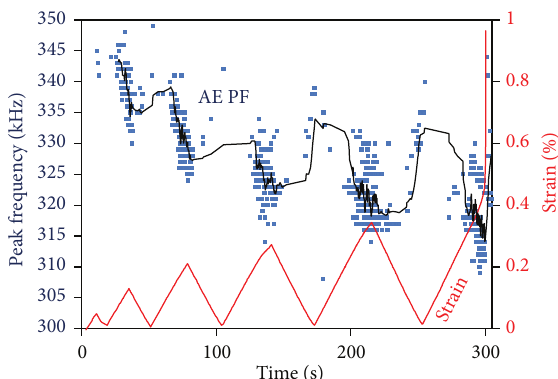
Figure 10: Strain and AE cumulative history for specimen B.